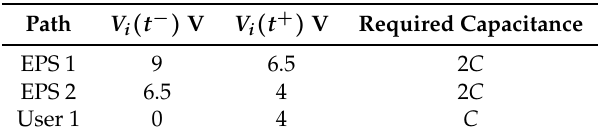
Table 5. Parameters’ setup and the required number of supercapacitors when the voltage differences of EPS 1 and EPS 2 are equal.